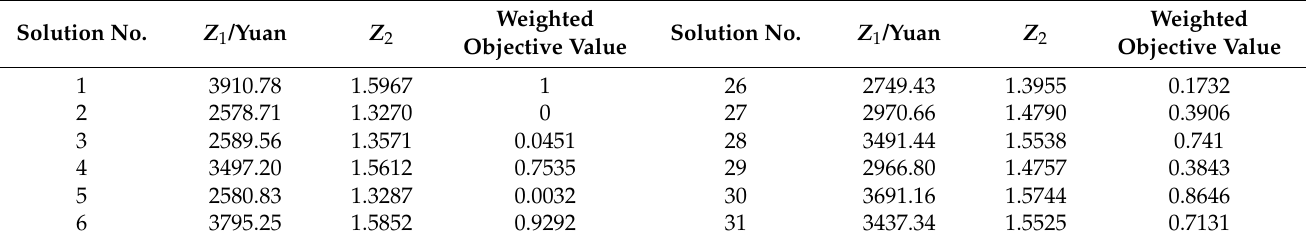
Table 3. Pareto solution set and weighted target value obtained by the entropy weight method. Solution